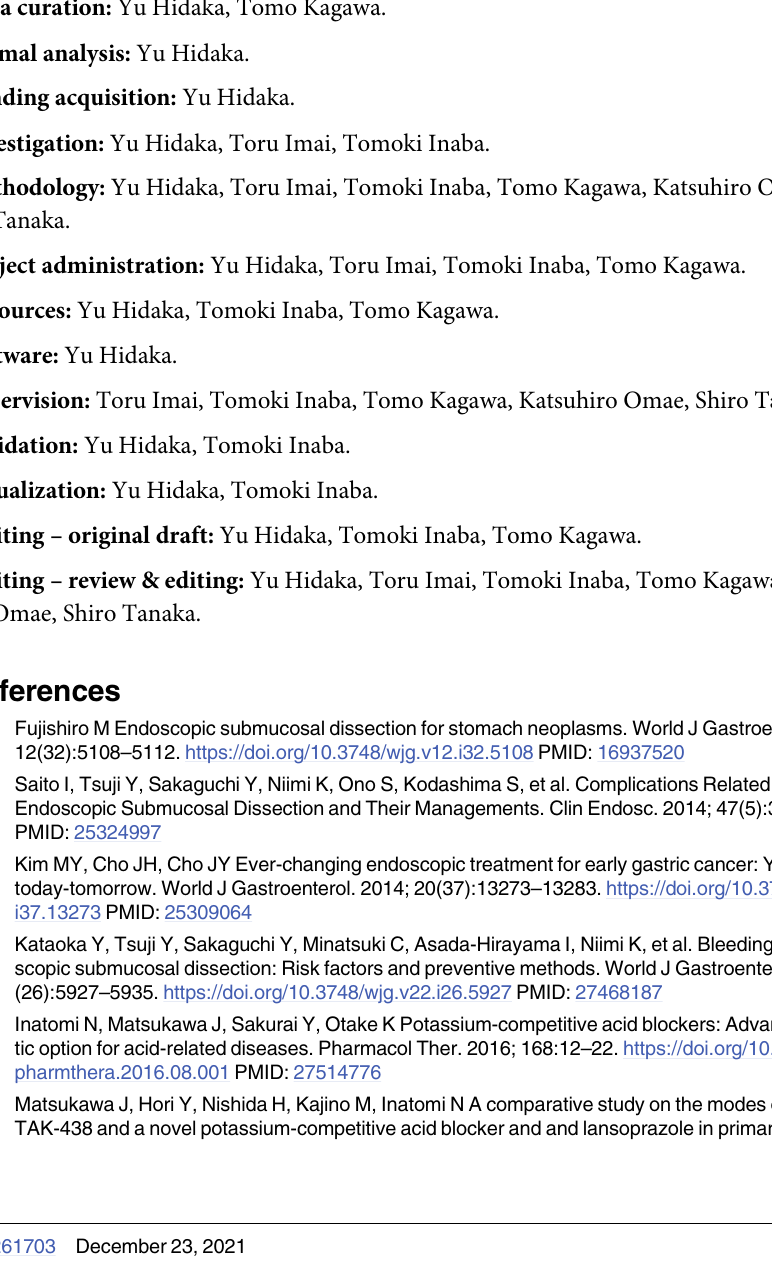
S1 Table. Example of full electronic search strategy used for the online